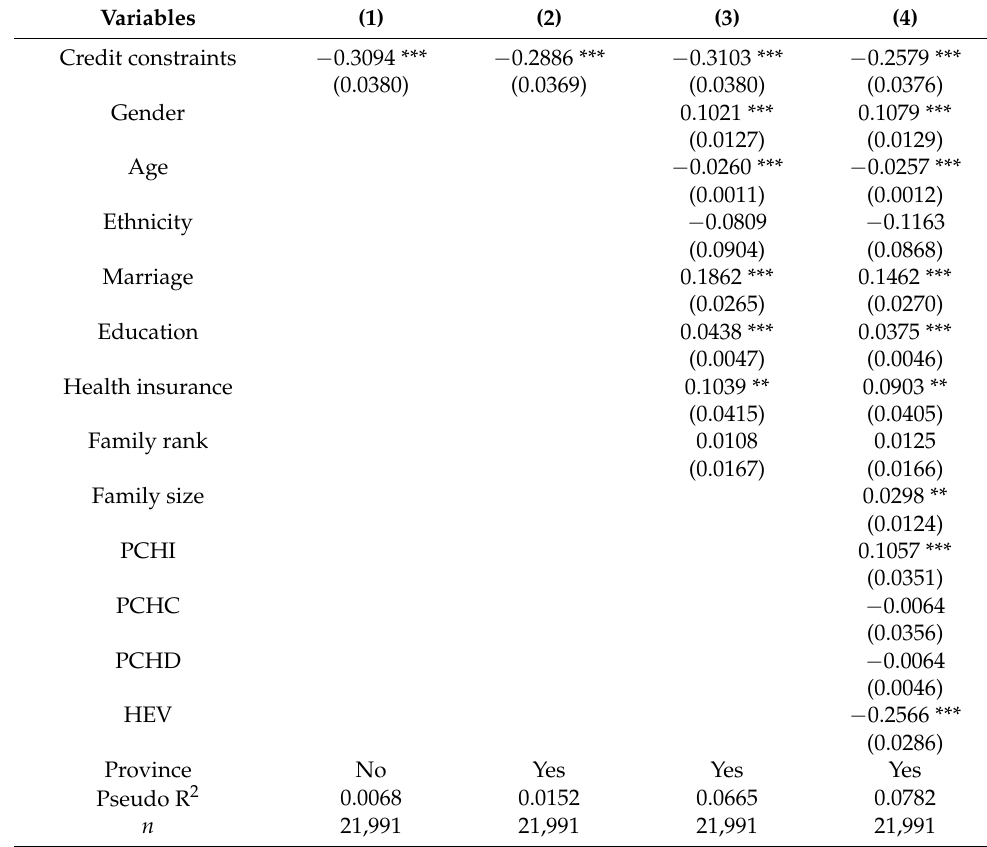
Table 2. Influence of formal credit constraints on rural residents’ self-rated health (ordered probit